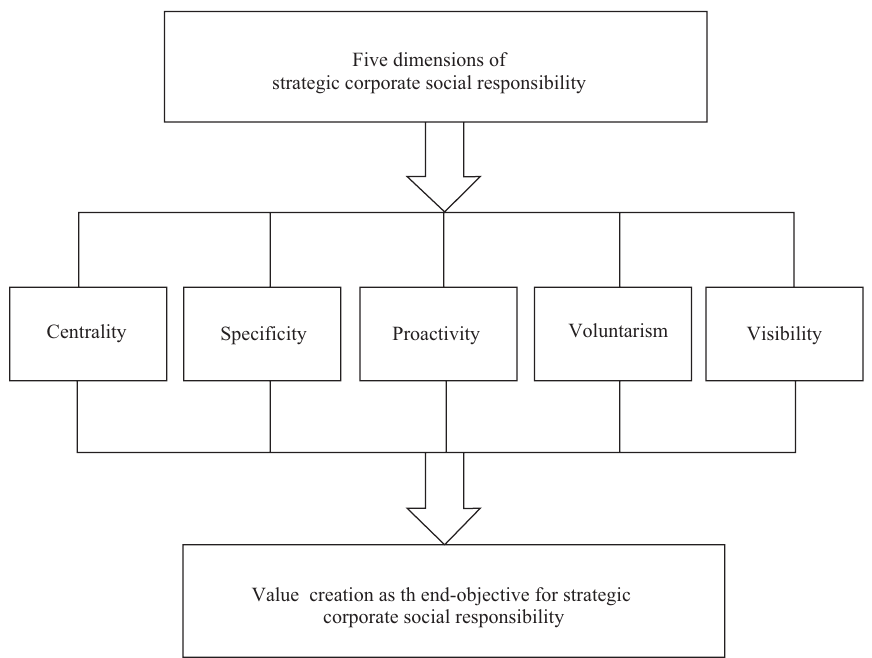
Fig. 2. The five dimensions of CSR and value creation as the intended outcome Source : Authors’